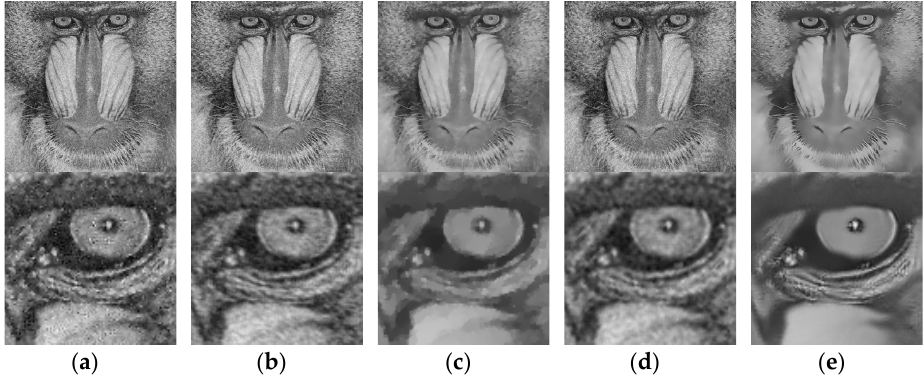
Figure 7. De-noising results for Baboon image with AWGN of σ = 30 ( a ) WF ( b ) 2DACSWF ( c ) SBITV ( d ) FMGF ( e ) Proposed method.